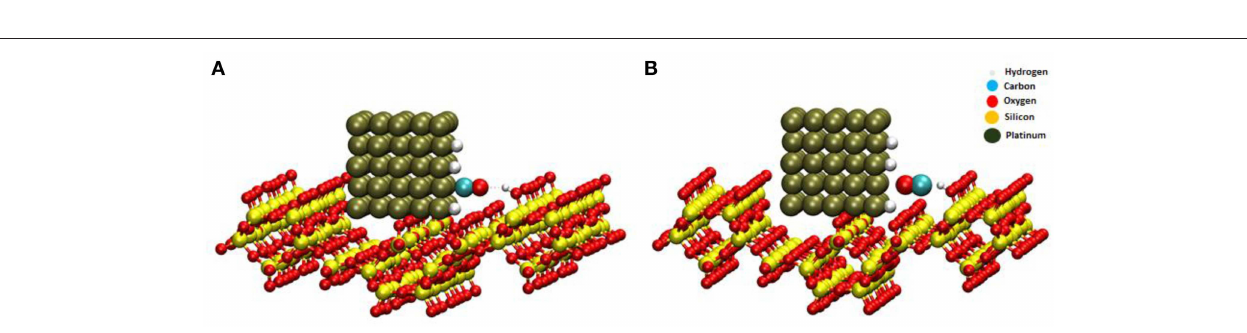
FIGURE 8 | CO adsporbs on the Pt NP via the C end (A) , and CO adsorbs to Pt NP via the O end (B)